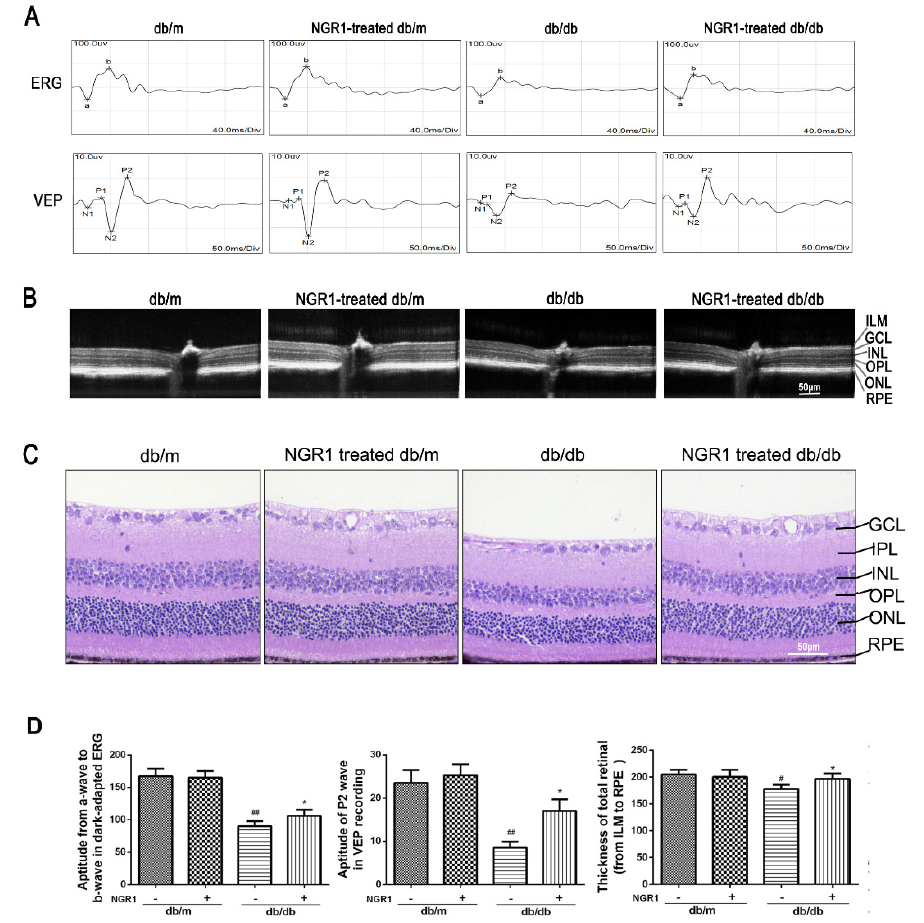
Figure 3. NGR1 pretreatment significantly attenuated DR in db / db mice. ( A ) Typical waveforms and quantitative analysis of ERG and VEPs amplitudes. ( B ) Retinal thickness was determined by OCT. ( C ) Retinal morphology was detected by HE. ( D ) Corresponding statistics of ERG, VEPs and OCT. The number of mice in this experiment was 10 (n = 10). The results are expressed as means ± SD. Two groups were analysed by unpaired two-tailed Student’s t -tests, and multiple groups were analysed by one-way analysis of variance (ANOVA); # indicates significant di ff erence from the control cells or db / m mice ( p < 0.05); ## indicates a significant di ff erence from control cells or db / m mice ( p < 0.01). * indicates a significant di ff erence from HG treatment or db / db mice ( p < 0.05); ** indicates significant di ff erence from HG treatment or db / db mice ( p < 0.01). ( + ), treatment with NGR1; ( − ), treatment without NGR1.